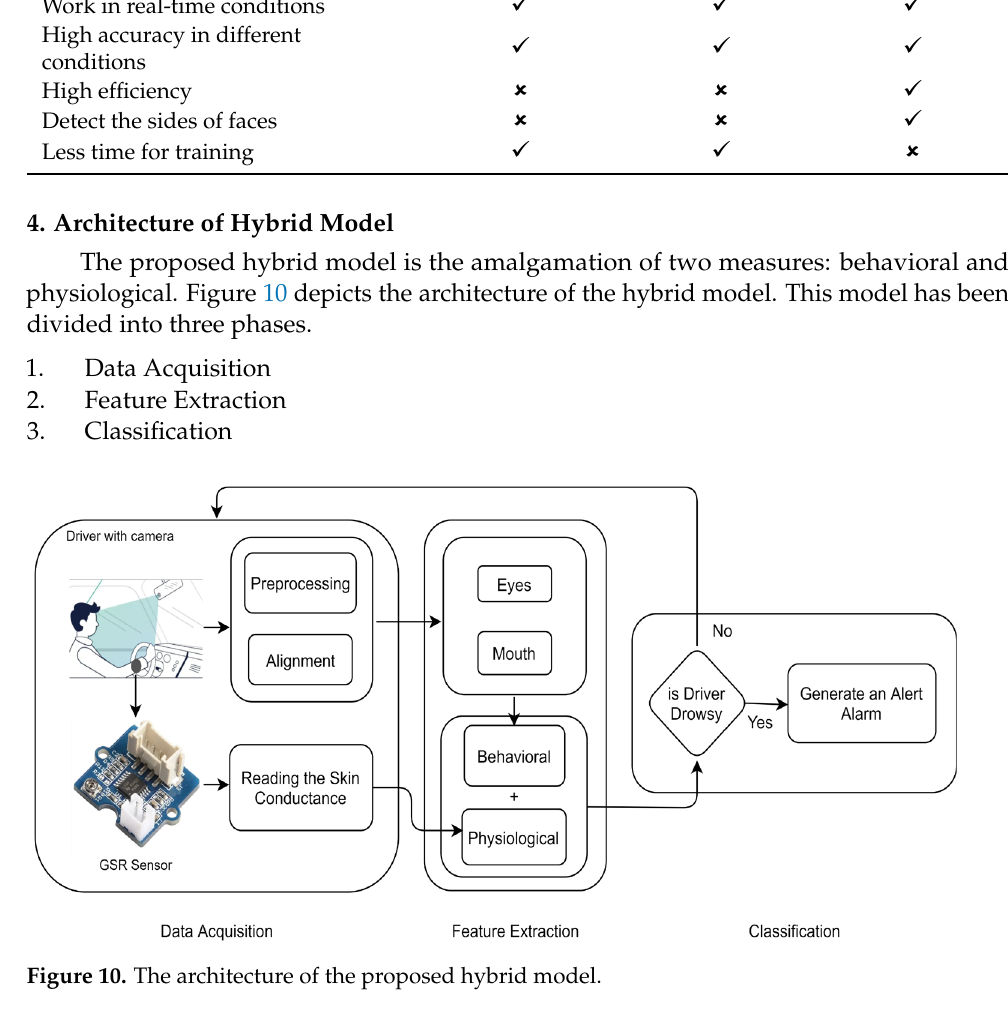
Table 3. Comparative analysis of various face detection techniques based on various parameters.